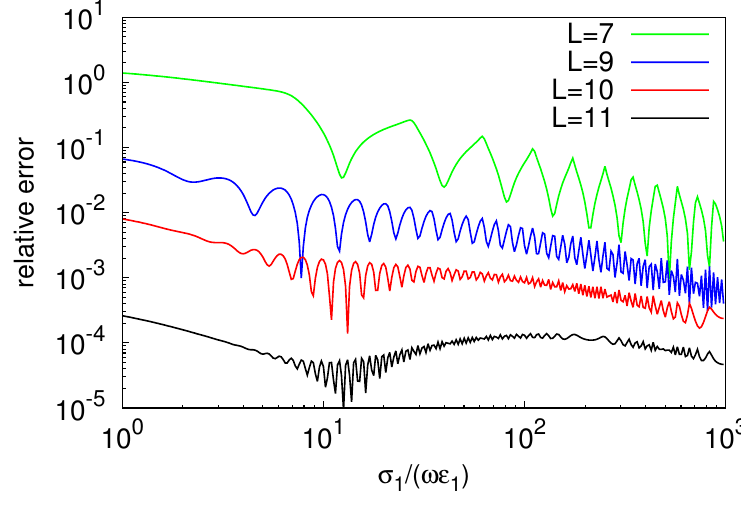
Figure 5. Amplitude of H y against the normalized conductivity of the ground σ 1 / ( ω(cid:101) 1 ) .